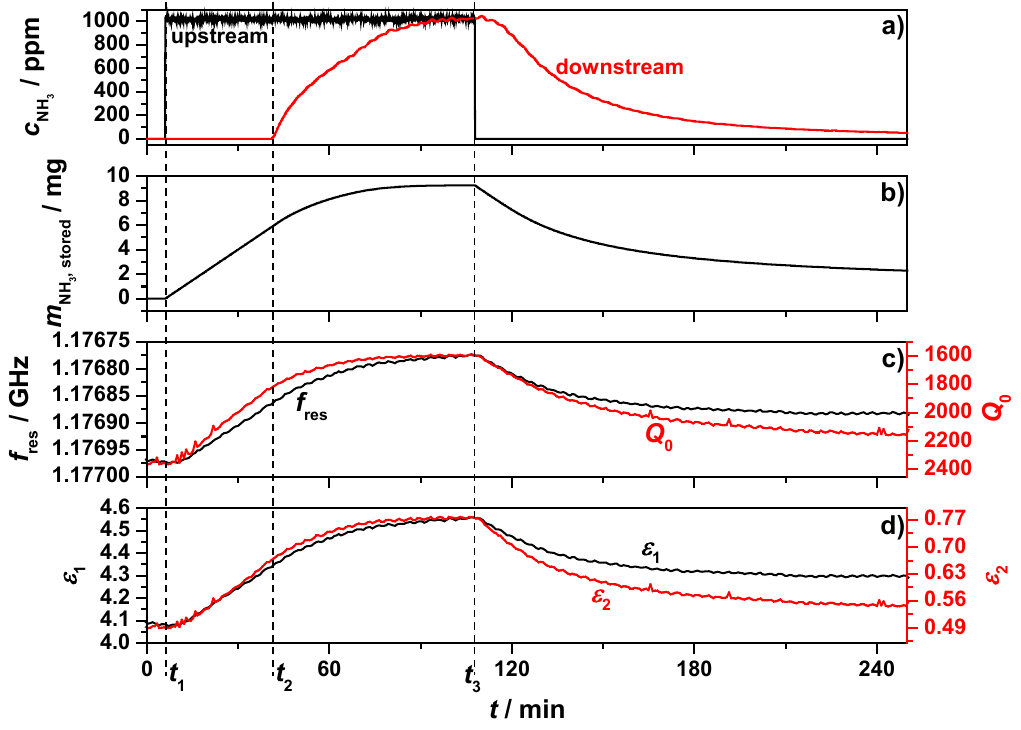
Figure 7. First measurement with the test setup: Upstream (inlet) and downstream (outlet) ammonia concentration ( a ), calculated stored amount of ammonia ( b ), resonance frequency and unloaded quality factor of the TM mode ( c ) and calculated effective values of the 010 complex permittivity ( d